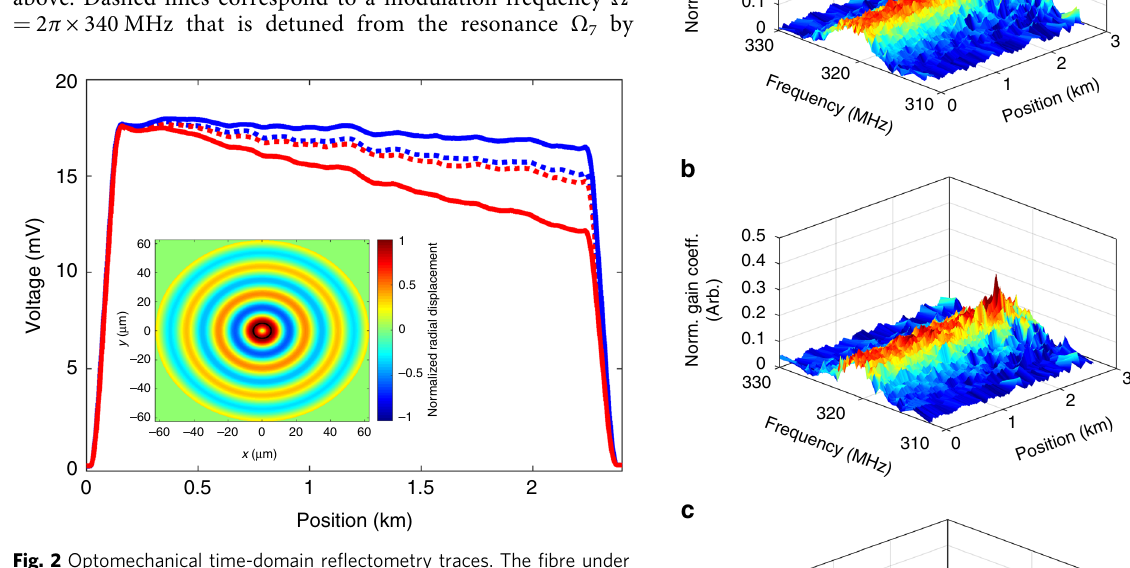
Fig. 2 Optomechanical time-domain re fl ectometry traces. The fi bre under test was 2.5 km long. Red traces present the Raleigh backscatter Ω ; where ω contributions of an optical fi eld at frequency ω 1 ¼ ω 0 þ 1 0 is 2 a central optical frequency and Ω is a radio-frequency offset. The offset is chosen near the resonance frequency Ω 7 of optomechanical coupling due to radial mode R 0,7 . Blue traces present the Rayleigh backscatter Ω . Traces were of a co-propagating fi eld of frequency ω 2 ¼ ω 0 (cid:2) 1 2 averaged over 1024 discrete choices of ω 0 within a wavelength range of 1558.5 – 1559.5 nm, with the offset Ω fi xed, in order to reduce coherent contributions to the Rayleigh backscatter. Dashed lines: Ω detuned from Ω 7 by several linewidths Γ 7 . Little coupling takes place between the two optical fi elds, and their local power levels are nearly equal along the entire fi bre. Fig. 3 Optomechanical time-domain re fl ectometry maps. The nonlinear Both are attenuated due to linear losses. Solid lines: Ω adjusted to match coef fi cients γ (7) ( Ω , z ) are presented as functions of frequency detuning Ω / Ω fi eld is reduced due to (2 π ) between two co-propagating optical fi elds and position z along a fi bre 7 . Attenuation of the lower-frequency optical under test. The nonlinear coef fi cients are normalized so that optomechanical coupling (solid blue), whereas that of the higher-frequency components is increased (solid red). The inset shows the calculated is the same for all measurements and all positions z . The dual-layer acrylate normalized transverse pro fi le of the material displacement of mode R 0,7 , in coating was removed from a 100 m-long fi bre section, located 2.5 km from the input end. The uncoated section was kept exposed in air ( a ), immersed a silica fi bre with 125 µ m diameter, as a function of Cartesian coordinates x in ethanol ( b ) or immersed in deionized water ( c and y